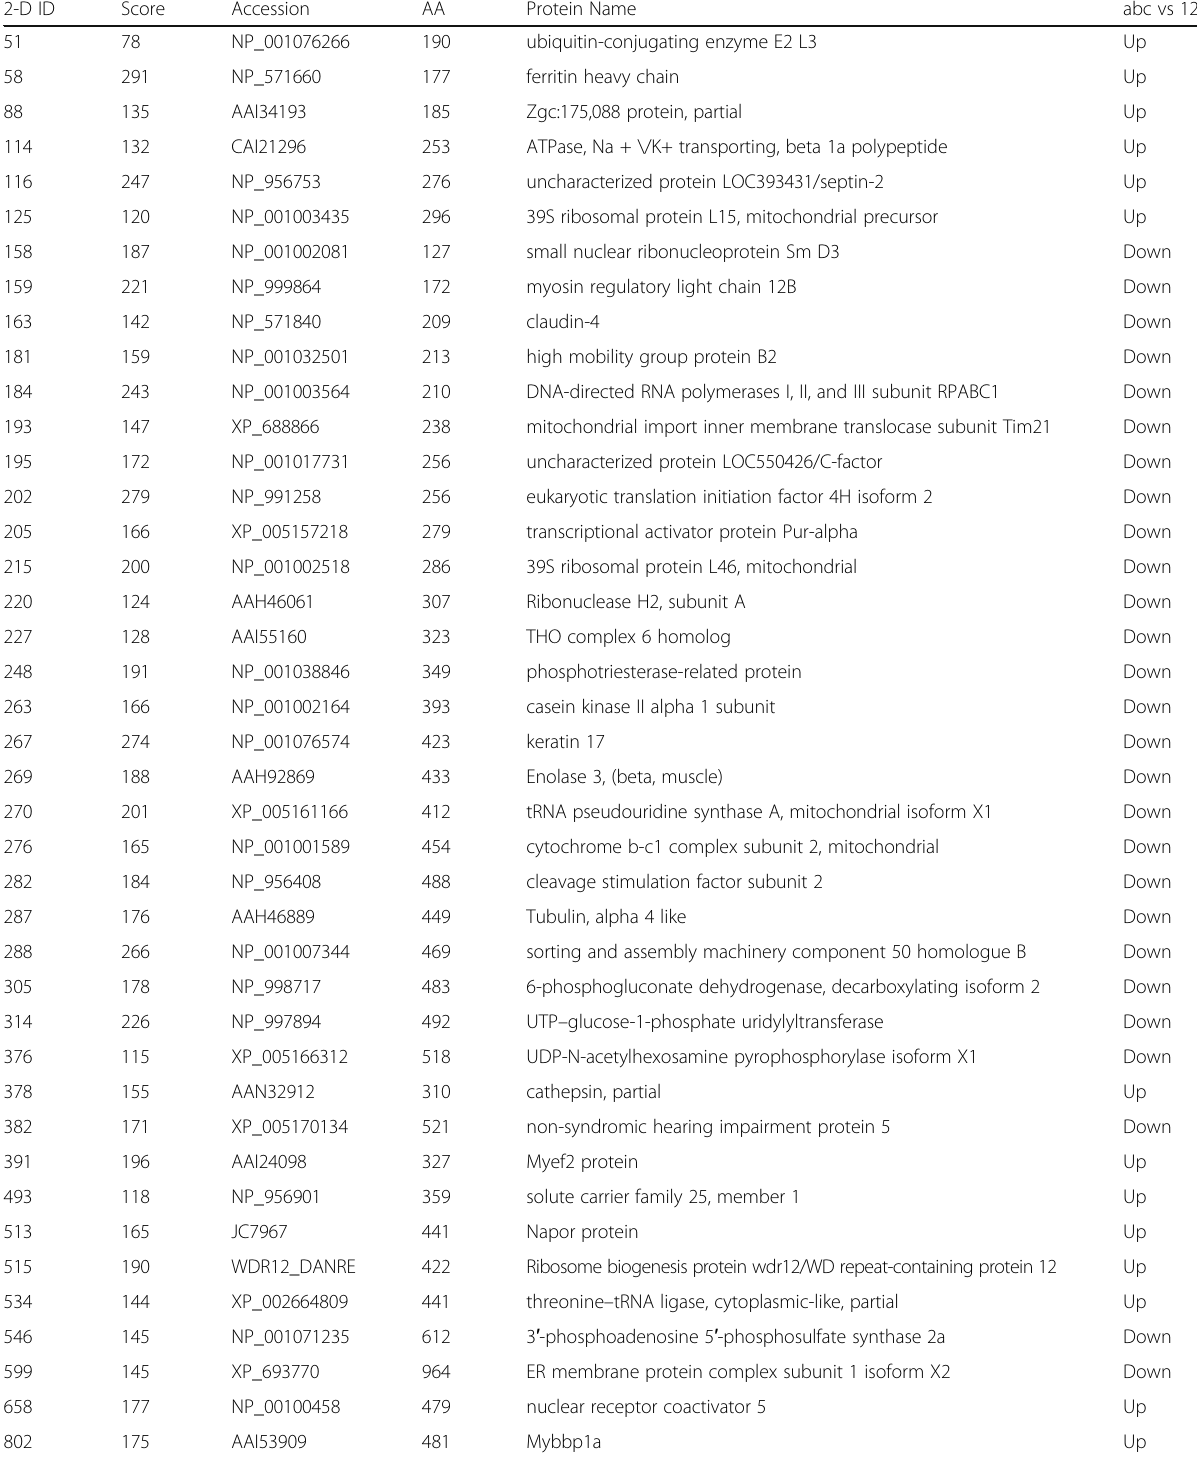
Table 4 Protein comparison of MS identification results between oridonin groups (a, b, c) and control groups